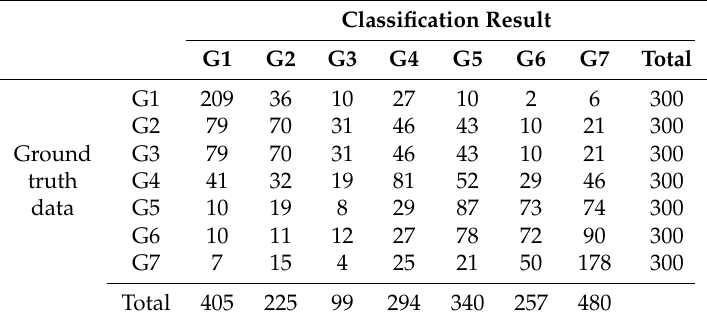
Table 5. Error matrix for seven-class classification (MLIT’s